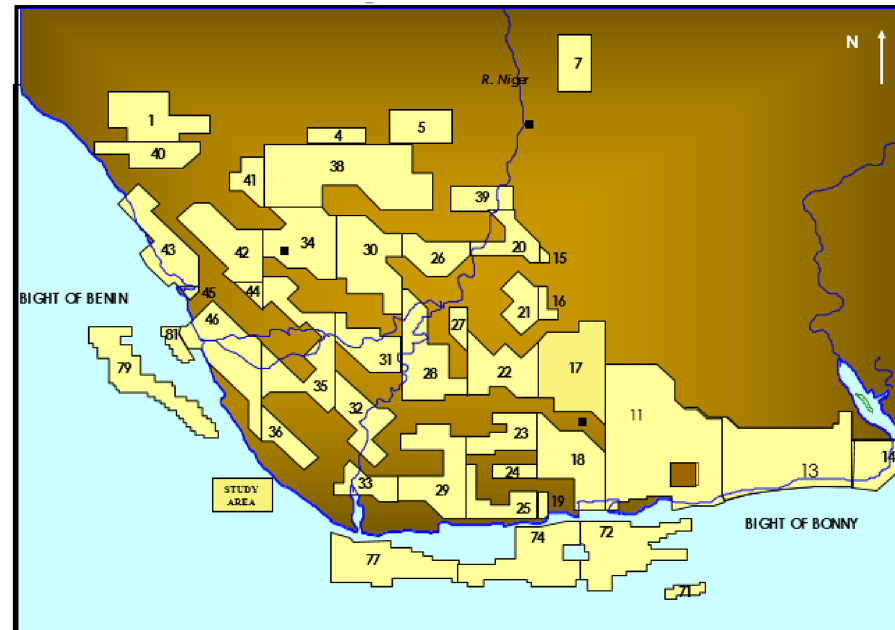
Fig. 2 Niger Delta concession map showing study area. Modi- fied from Doust and